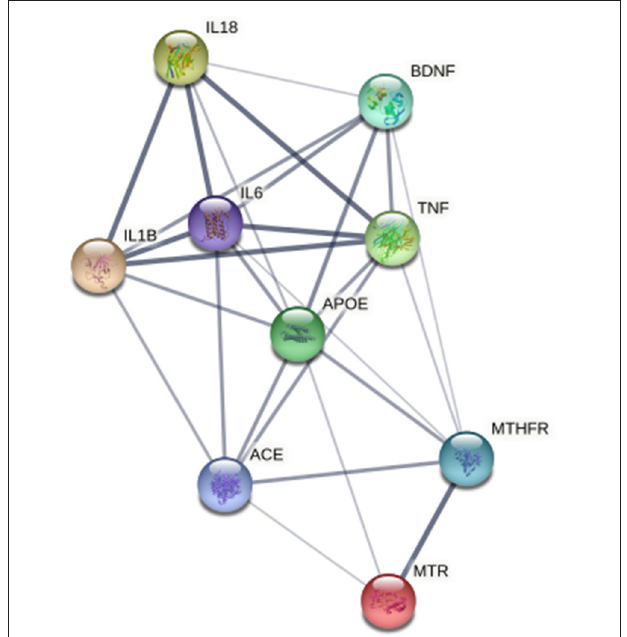
FIGURE 5 | Network, constructed by the STRING Protein–Protein interaction network tool, depict interactions, among the 7 genes targeted by miRNA associated with Brain-Derived Neurotrophic Factor and related to both atherothrombosis and depression. The line thickness represents strength of the